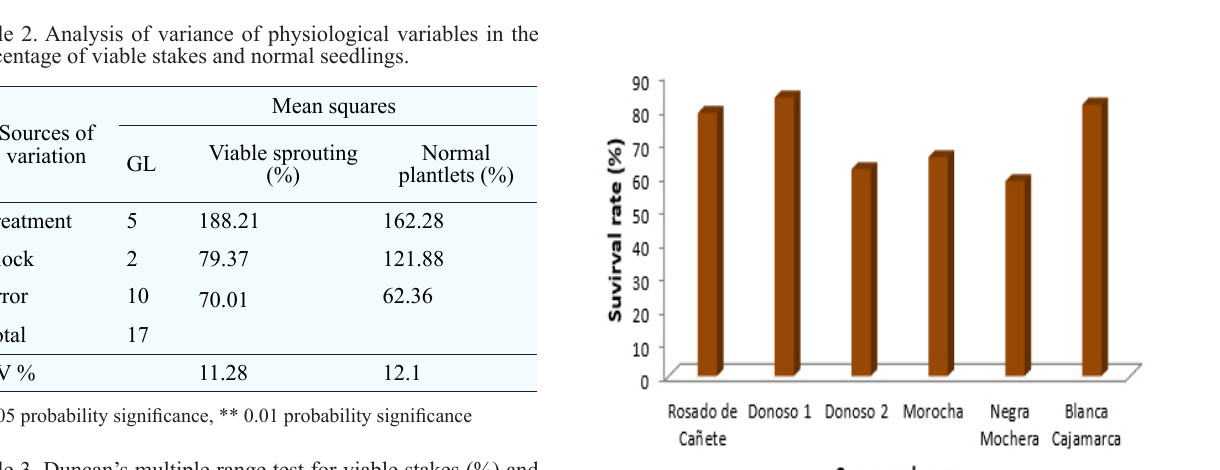
Table 3. Duncan’s multiple range test for viable stakes (%) and normal seedling (%)